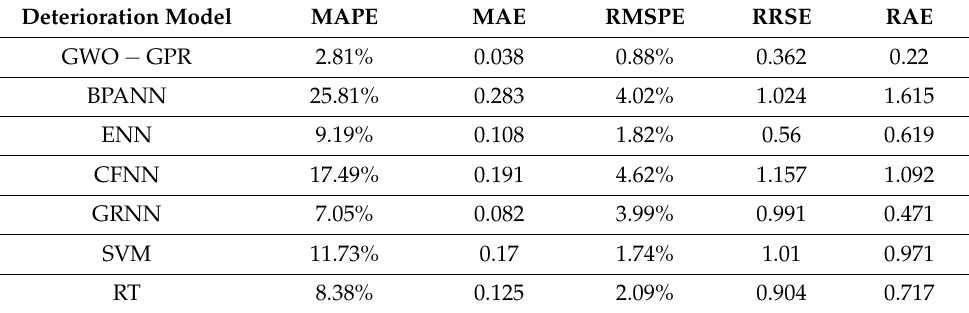
Table 6. Performance comparison between deterioration prediction models of concrete ceiling slab. Deterioration